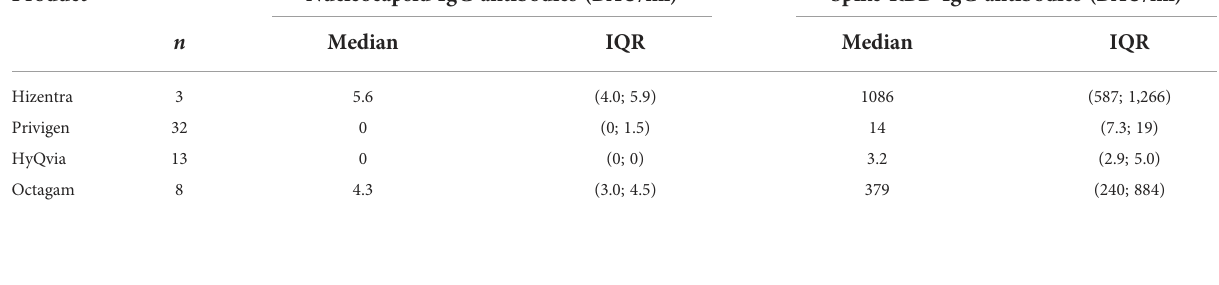
FIGURE 2 Anti-spike protein receptor-binding domain IgG antibody levels after different doses of SARS-CoV-2 vaccination and treatment with monoclonal antibodies in individuals with common variable immunode fi ciency. The anti-spike receptor-binding domain IgG antibody response after SARS- CoV-2 vaccination (left fi gures, A and C ) and after monoclonal antibody treatment (right fi gures, B and D ). In the left fi gures, samples collected after administration of monoclonal antibodies were excluded. Data were compared using paired Wilcoxon sign rank tests. Scatters were colored according to immunoglobulin replacement therapy (upper fi gures, A and B ) and COVID-19 (previous vs. naïve) at the time of sampling (lower fi gures, C and D ). One and three months after the third dose and 1 month after the fourth dose, there were no signi fi cant variation in spike IgG